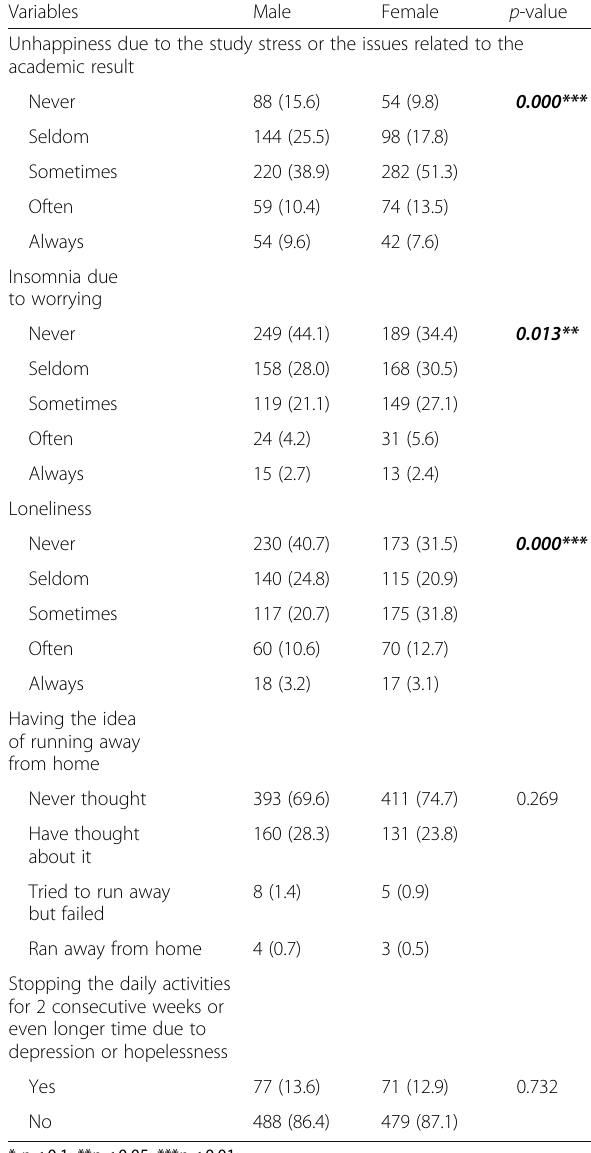
Table 5 Mental health variables between male and female among left-behind children Variables Male Female p